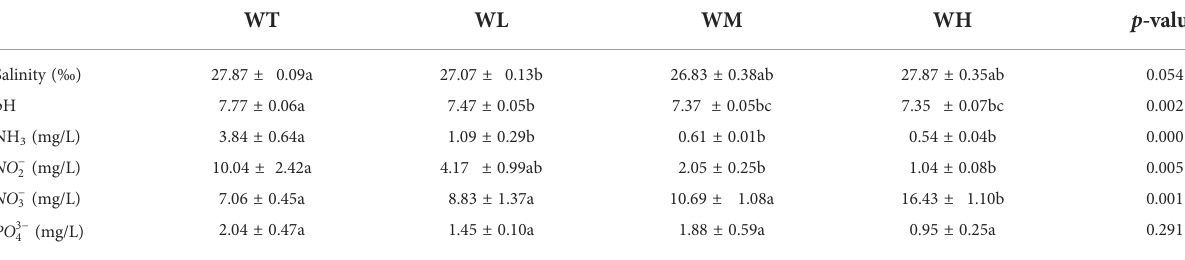
TABLE 1 Water quality parameters of the culture seawater with and without probiotic